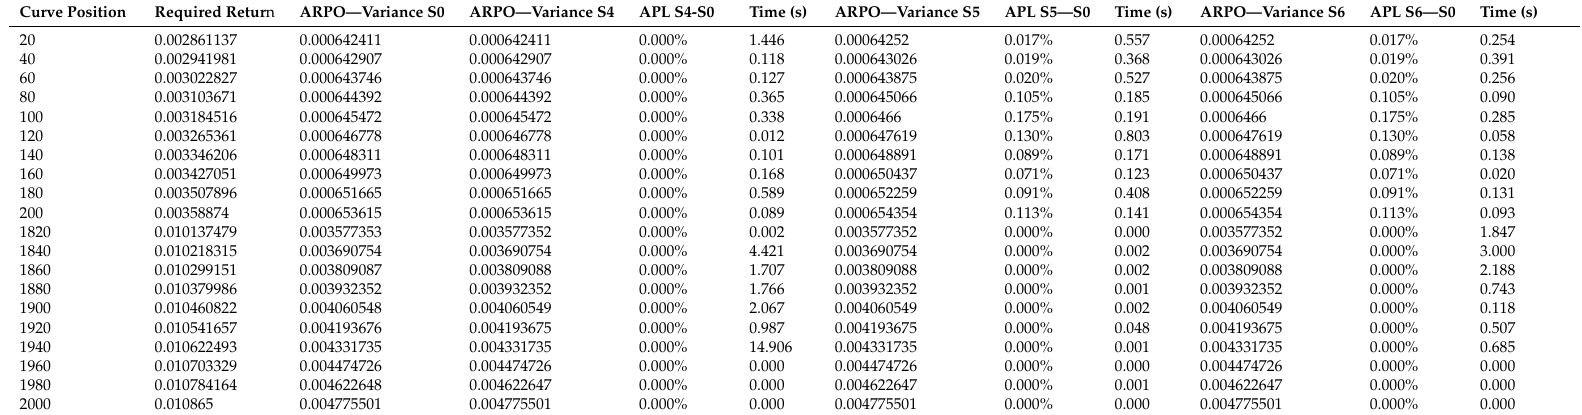
Table 8. Comparison of results for different scenarios based on Instance 1 (Hang Seng) varying problem cardinality constraints. Curve